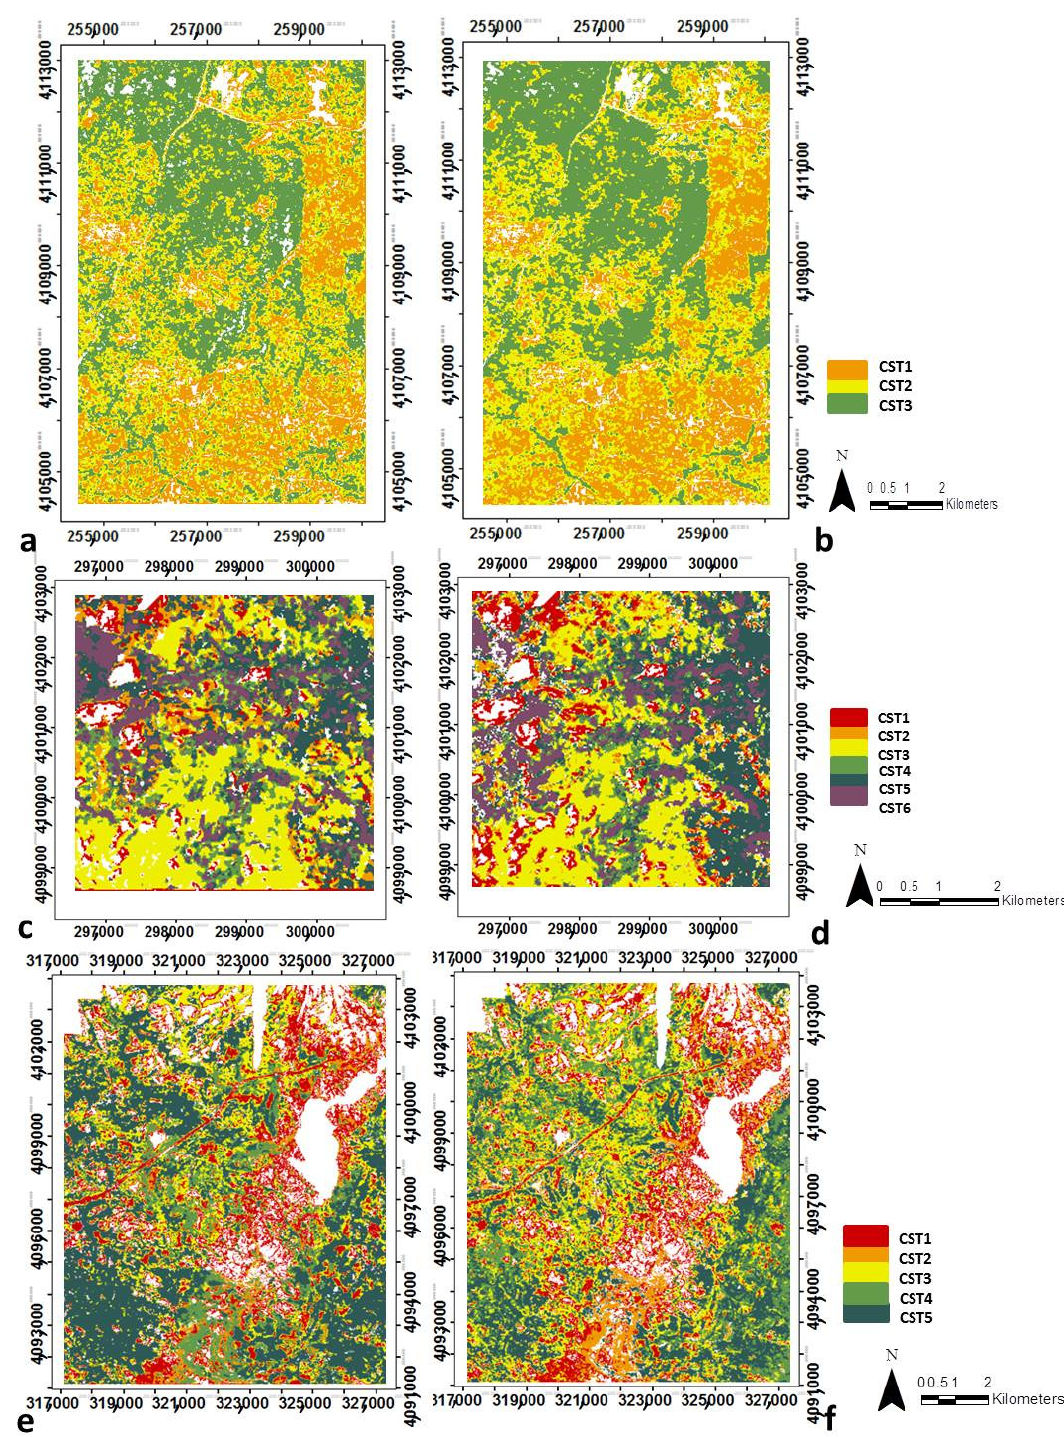
Figure 7. Spatial distribution of the structural types (CST) in SJER using reference data i.e., LiDAR-derived data ( a ) and IS-derived data ( b ); similarly in SOAP these are ( c ) and ( d ); and in TEAK ( e ) and ( f ). Note regions are not to scale due to optimizing images and site size differences. Table 4. Description of SJER, SOAP, and TEAK canopy structural types (CSTs) using LiDAR-derived variables and IS-derived variables. B: Biomass (from 0 to 1), H: Height (m), VH: Vegetation heterogeneity (m), and C: Clumping (from 0 to 1).